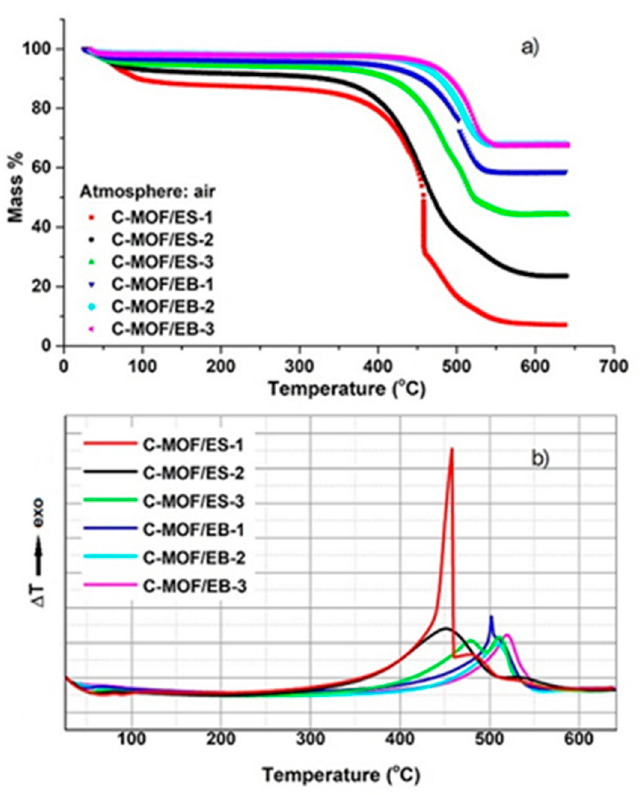
Figure 5. ( a ) TGA and ( b ) DTA curves of C-(MOF-5/PANI) samples, recorded in an air stream.